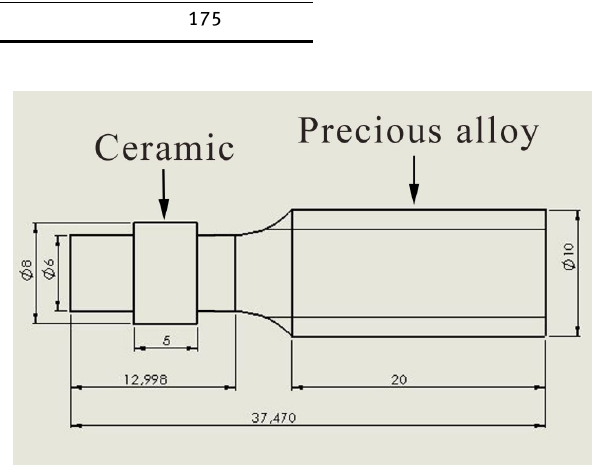
Figure 1: Geometry of the alloy-ceramic specimen (dimensions in mm)